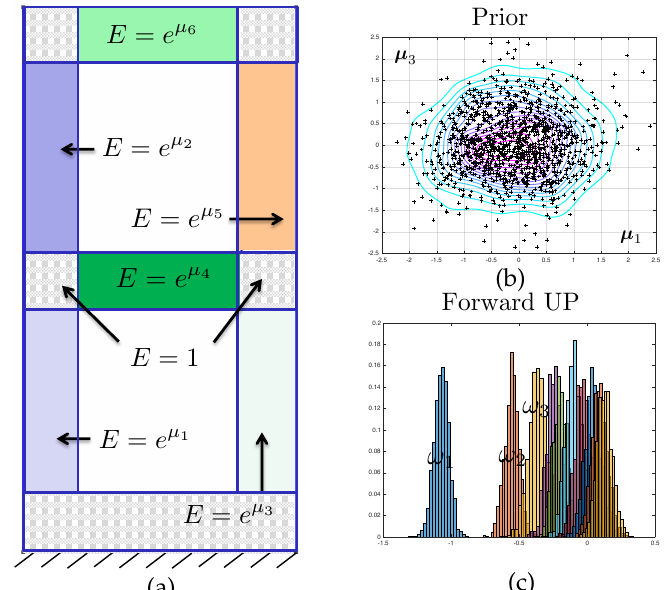
Figure 1. ( a ) Structure undergoing structural vibrations. The grey area have a known, deterministic Young modulus. This property is piecewise constant in the coloured areas, and Gaussian distributed. ( b ) The corresponding marginal probability density function for two of the 6 parameters is represented in the top-left corner. ( c ) Standard Monte-Carlo finite element process is employed to compute the distribution of the 10 first free vibration frequencies and represent the marginal distribution of each of these